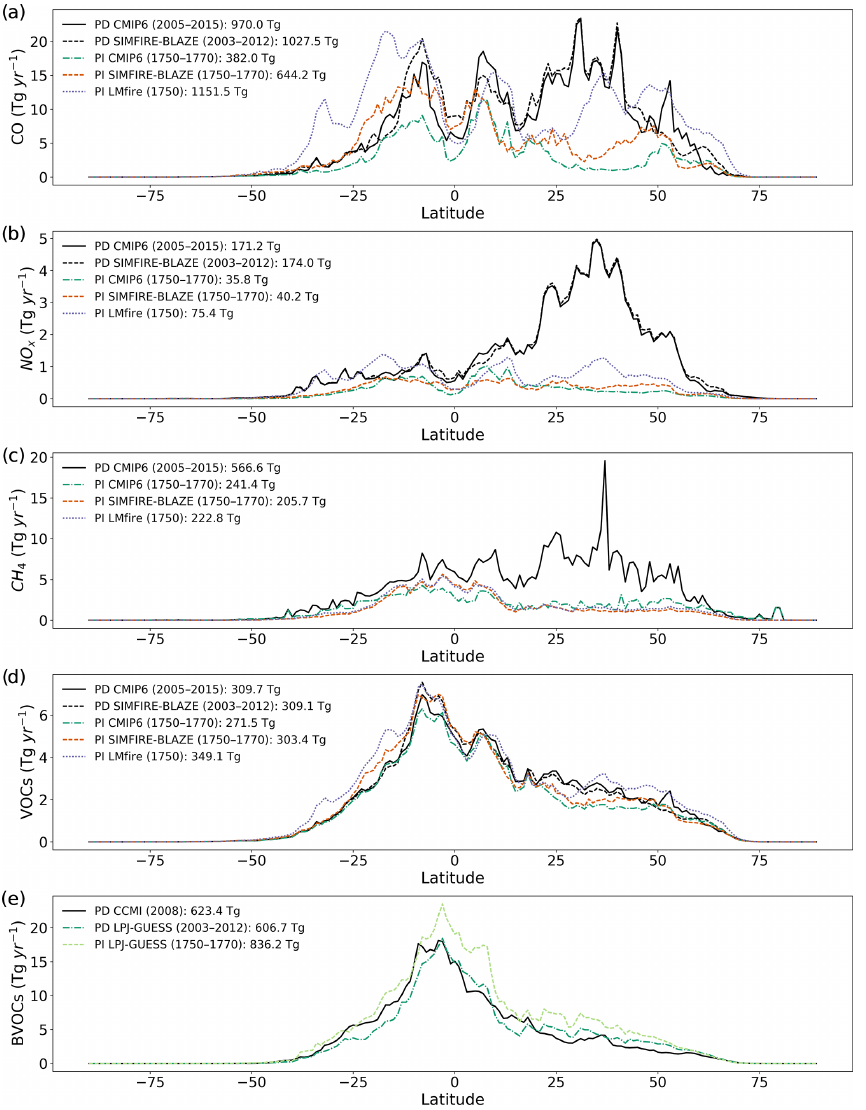
Figure 1. Annual latitudinal mean pre-industrial emissions (Tgyr − 1 ) of (a) CO, (b) NO x , (c) CH 4 and (d) VOCs in the PD CMIP6 (solid black line), PD SIMFIRE-BLAZE (dashed black), PI CMIP6 (dashed green), PI SIMFIRE-BLAZE (dotted orange) and PI LMfire (dashed purple) inventories. (e) Annual latitudinal mean BVOC emissions (Tgyr − 1 ) in PD CCMI (solid black line), PD LPJ-GUESS (dashed dark green) and PI LPJ-GUESS (dotted light